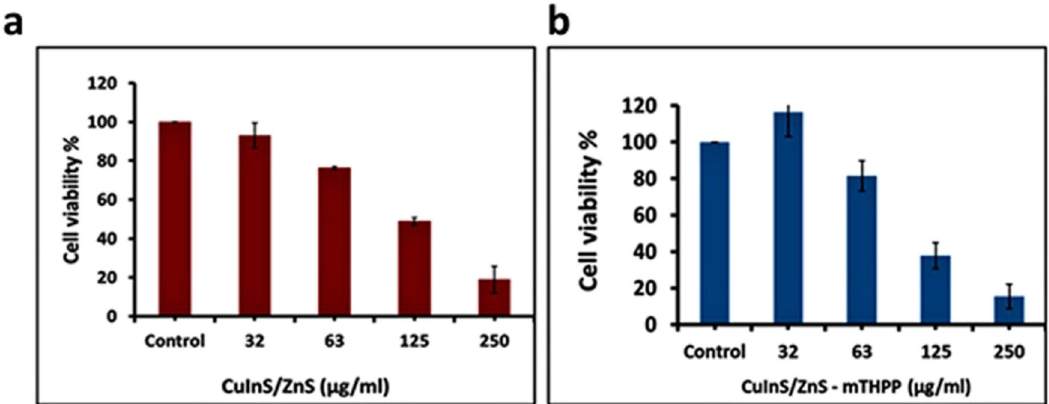
Figure 7: Cytotoxicity e ff ect of: ( a ) CIS/ZnS QD and ( b ) CIS/ZnS – mTHPP conjugate against THP - 1 cancer cells; with permission from ref. [ 127 ] ; Springer